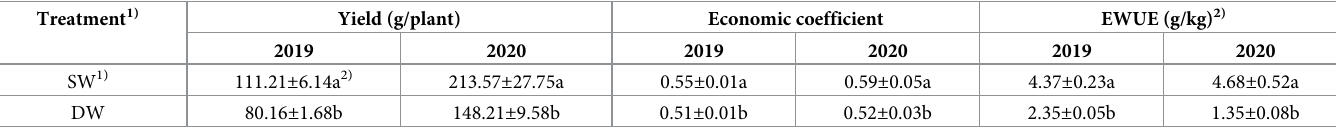
Table 4. Yield, economic coefficient and water use